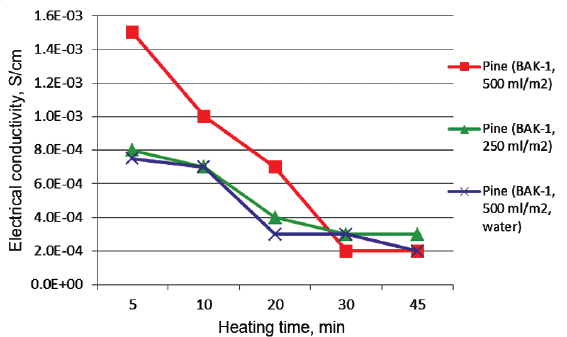
fig. 9. the dependency of the average electrical conductivity on heating time for media 3, 4 and